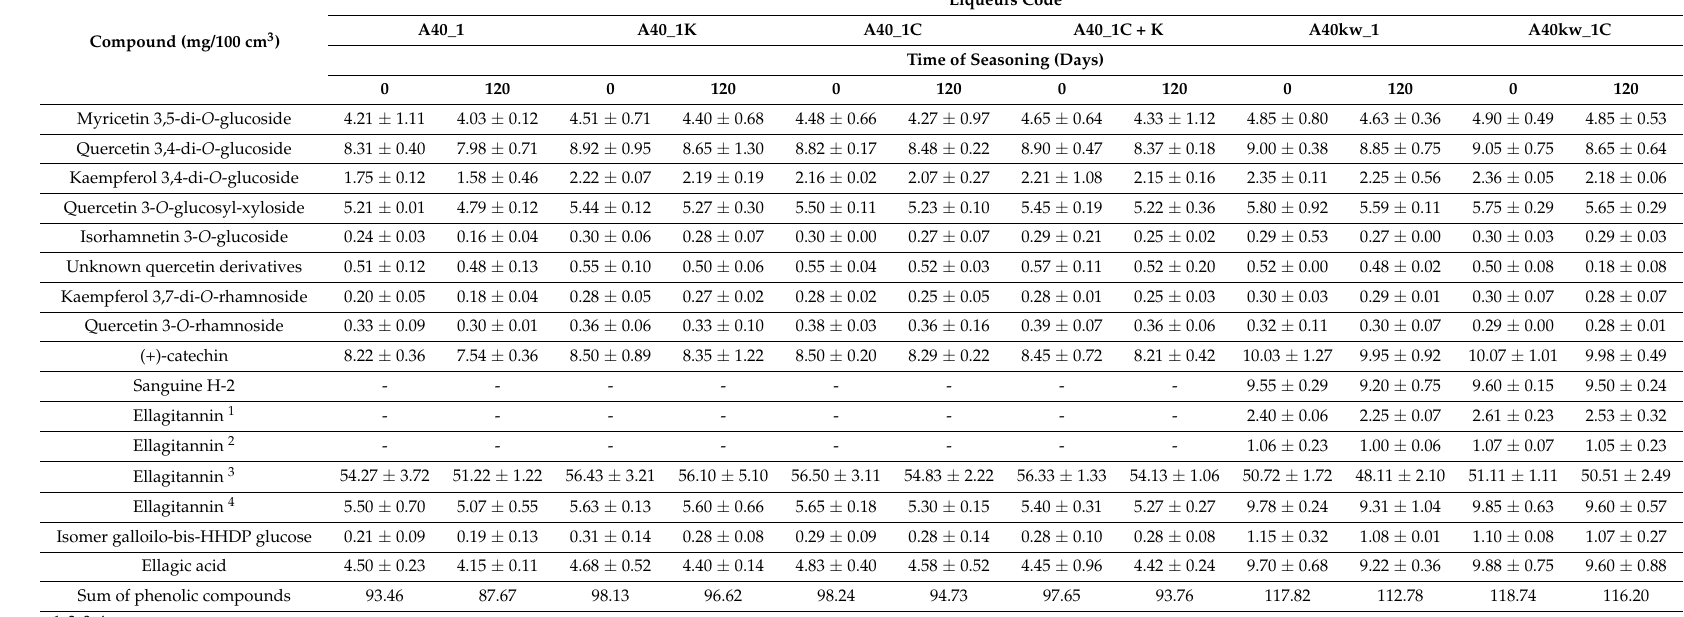
Table 2. Content of polyphenolic compounds in liqueurs from Rosa rugosa petals macerated with 40% ethanol, during 120 days of